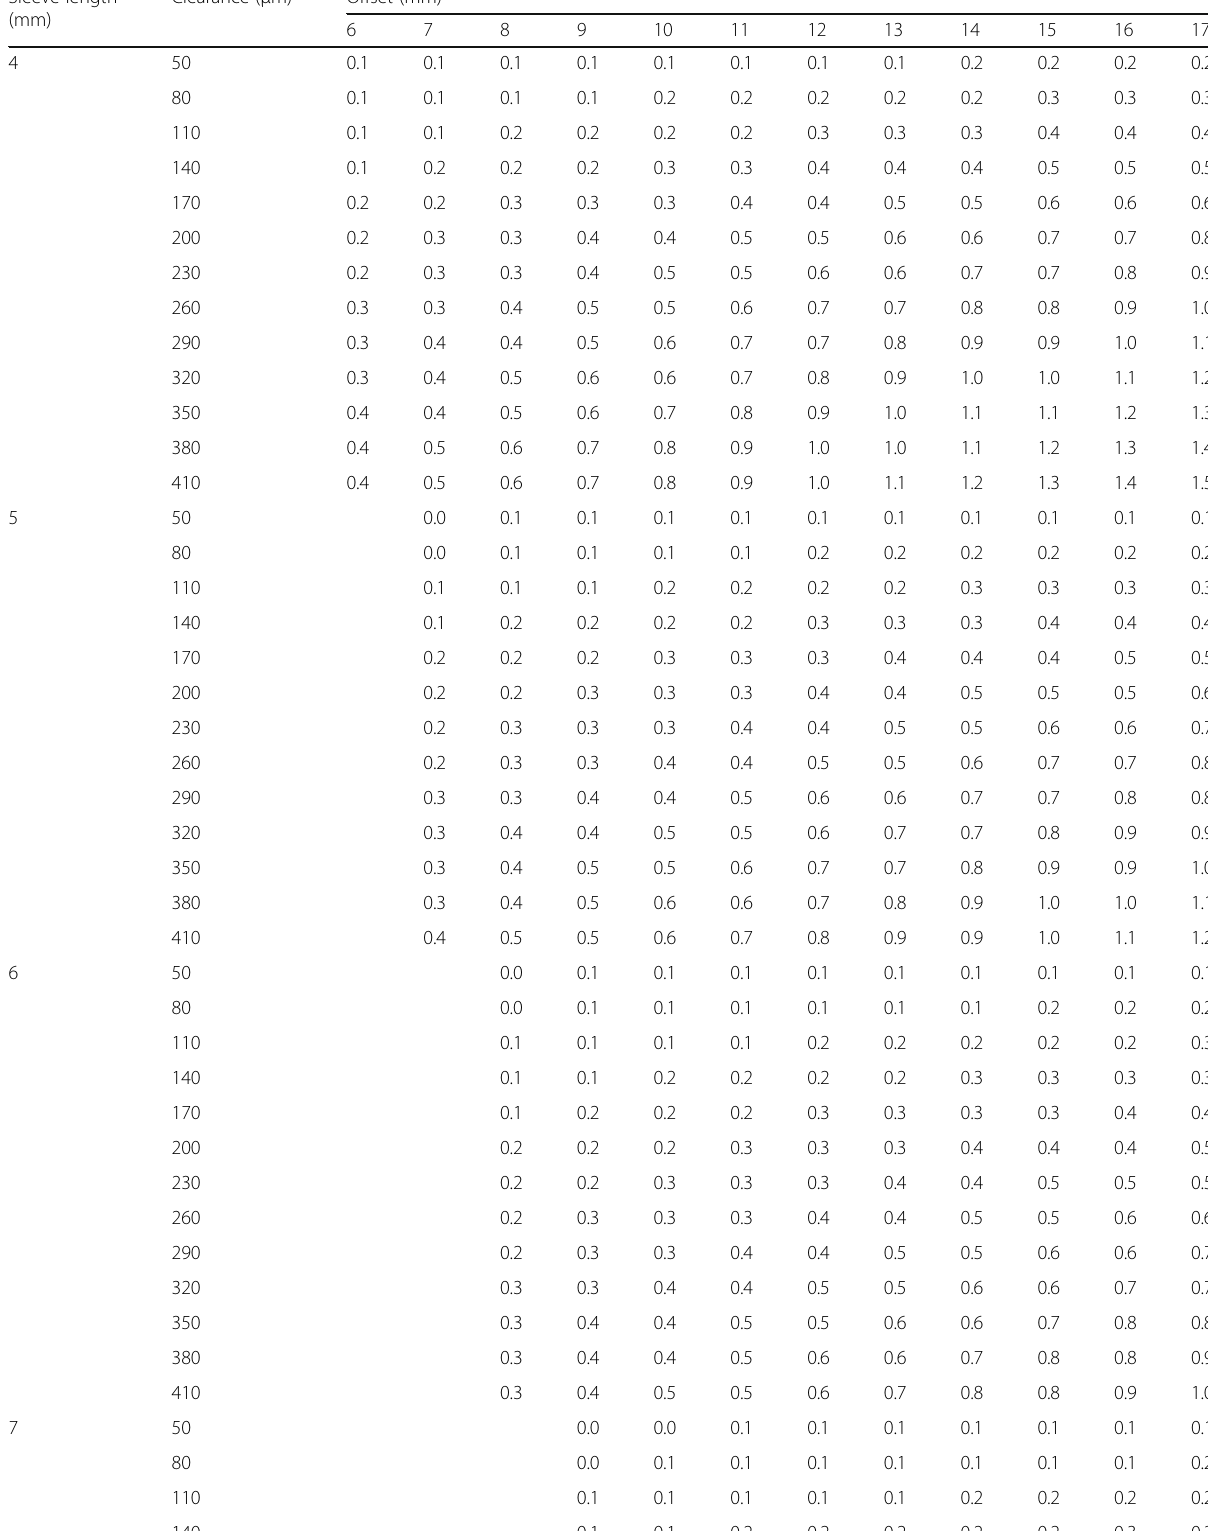
Table 4 Error at the neck